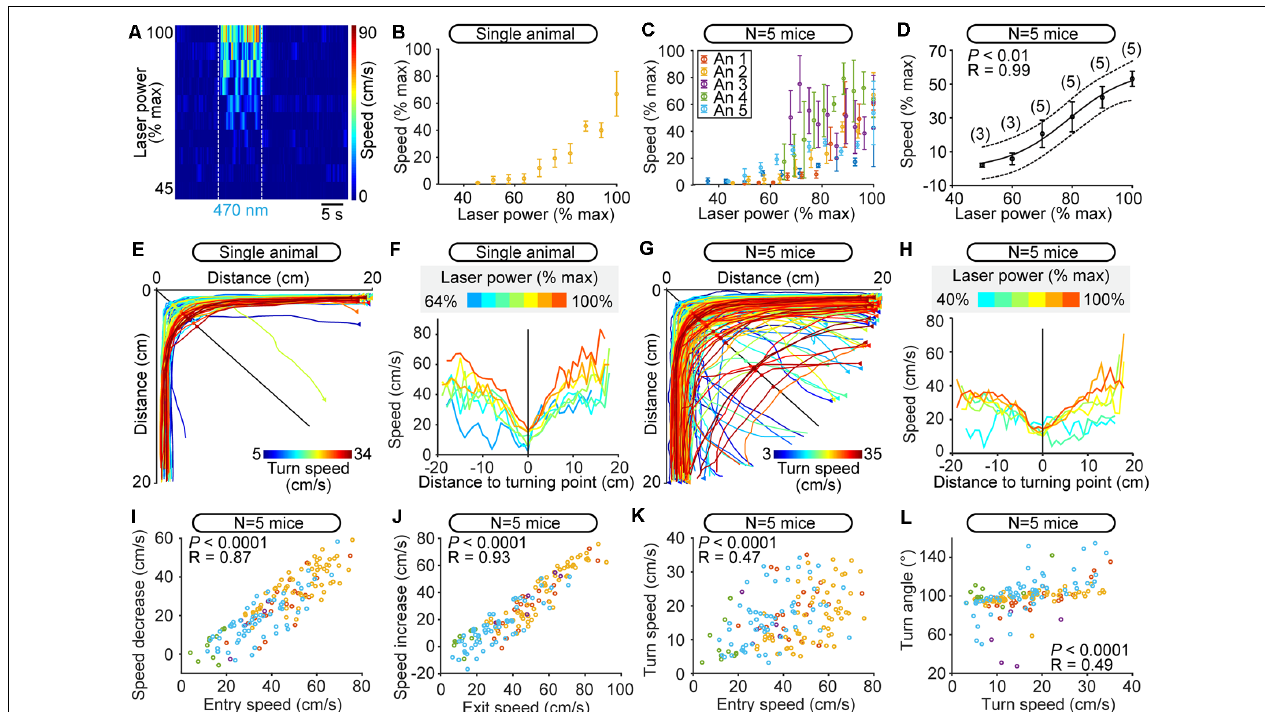
FIGURE 6 | Robustness of scaled control of speed during turning at different speeds controlled by the level of optogenetic stimulation of the cuneiform nucleus (CnF) in Vglut2-ChR2-EYFP mice in the open-field arena. (A) Color plot illustrating the increase in overall locomotor speed in the open-field arena (cm/s) evoked by increases in laser power (6–13% of laser power) in a single animal (470 nm laser, 10 s train, 20 Hz, 10 ms pulses). Speed was calculated during the 10 s stimulation period, during which multiple turns could occur. Plotted laser powers were normalized as a percentage of their maximal value used per animal (% max). Each line illustrates the speed as a function of time for a given laser power expressed as a percentage of maximal laser power used for this animal. White dotted lines indicate the onset and offset of optogenetic stimulation. Warmer colors (red) indicate higher speeds. (B) Locomotor speed (1–42 cm/s) as a function of laser power (6–13% of laser power) in one animal. Each dot represents the speed (mean ± SEM) over three stimulations. Speed and laser power were normalized as a function of their maximal values (% max). (C) Relationship between locomotor speed (0.2–42.0 cm/s) and increasing laser power (6–27% of laser power) for all animals. Data from each mouse are illustrated with a different color. Each dot represents the speed (mean ± SEM) over three stimulations. Speed and laser power were normalized as a percentage of their maximal values per animal (% max). (D) Relationship between locomotor speed (mean ± SEM) and laser power in the same animals as in C , this time with data binned as a function of maximal laser power used per animal (% max) with a bin size of 10%. Speed and laser power were normalized as a percentage of their maximal values per animal (% max). The data followed a sigmoidal function (solid black line, P < 0.01, R = 0.99). The dotted lines illustrate the 95% prediction intervals. (E–G) Raw data showing the extracted locomotor trajectories in the corners of the arena during optogenetic-evoked locomotion in a single animal (E) and in five animals (G) Triangles illustrate movement onsets. Dots illustrate diagonal crossings. Warmer colors (red) illustrate higher turn speeds. (F–H) Locomotor speed as a function of the distance to the diagonal during the turns for increasing power of optogenetic stimulation of the CnF in a single animal ( F , 470 nm laser, 10 s train, 20 Hz, 10 ms pulses, 6–13% of laser power) and in five animals ( H , 470 nm laser, 10 s train, 20 Hz, 10 ms pulses, 6–27% of laser power). Warmer colors (red) indicate stronger optogenetic stimulation of the CnF. Laser powers were normalized as a percentage of their maximal value used per animal (% max) and were binned in H (bin width: 10%). In (F) , each curve was obtained from 1 to 14 turns in a single animal. In (H) , each curve was obtained from 2 to 73 turns pooled from five animals. (I) Relationship between the speed at corner entry, and the difference between entry speed and turn speed (linear fit, P < 0.0001, R = 0.87, N = 157 turns pooled from 150 stimulations, 30 stimulations per animal). (J) Relationship between the speed at corner exit, and the difference between exit speed and turn speed (linear fit, P < 0.0001, R = 0.93). (K) Relationship between the speed at corner entry and the turn speed (linear fit, P < 0.0001, R = 0.47). (L) Relationship between the turn speed and the turn angle (linear fit, P < 0.0001, R =